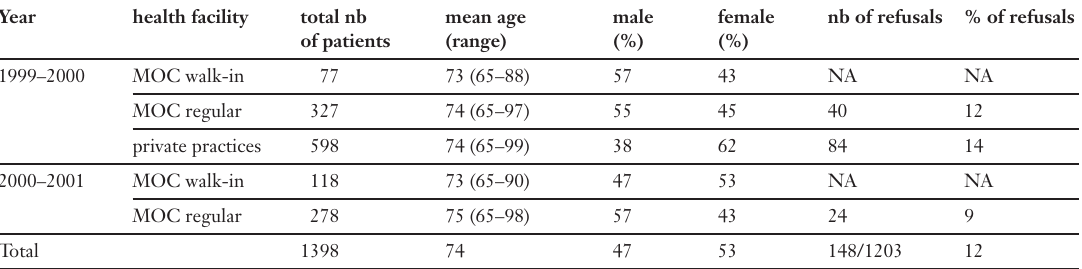
Demographical char- acteristics and preva- lence rates of refusal according to season and health